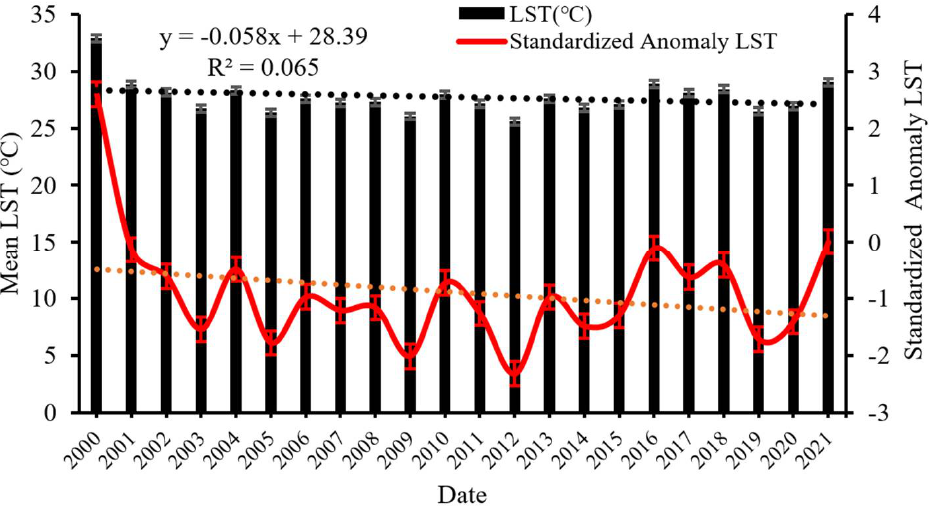
Figure 4. Time series of yearly LST and standardized LST anomaly in Afghanistan in the period 2000–2021.